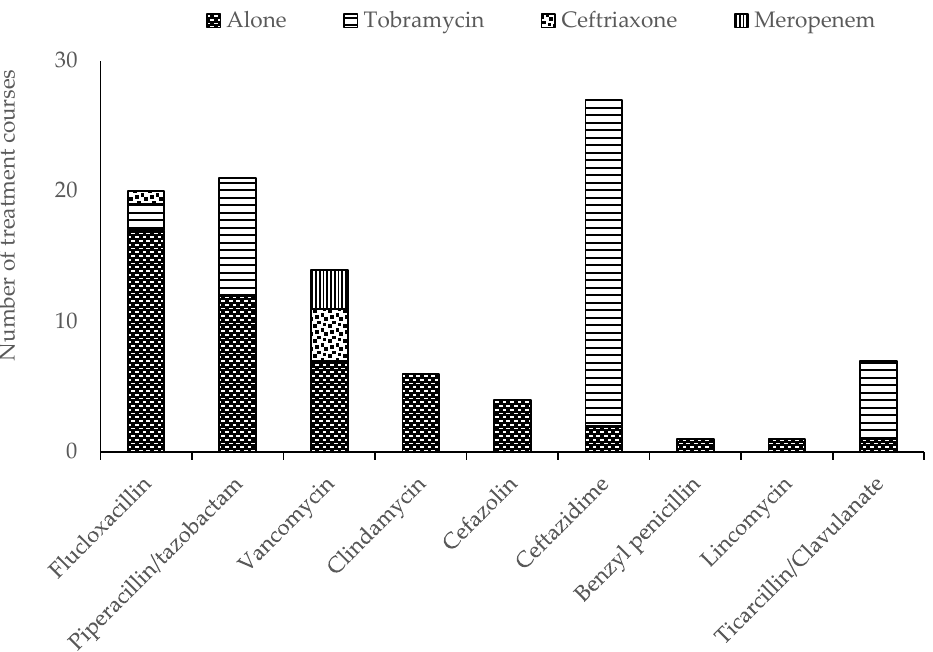
Figure 1. Parenteral antimicrobial therapy prescribed for the administration to children receiving outpatient parenteral antimicrobial therapy (OPAT) in the home.